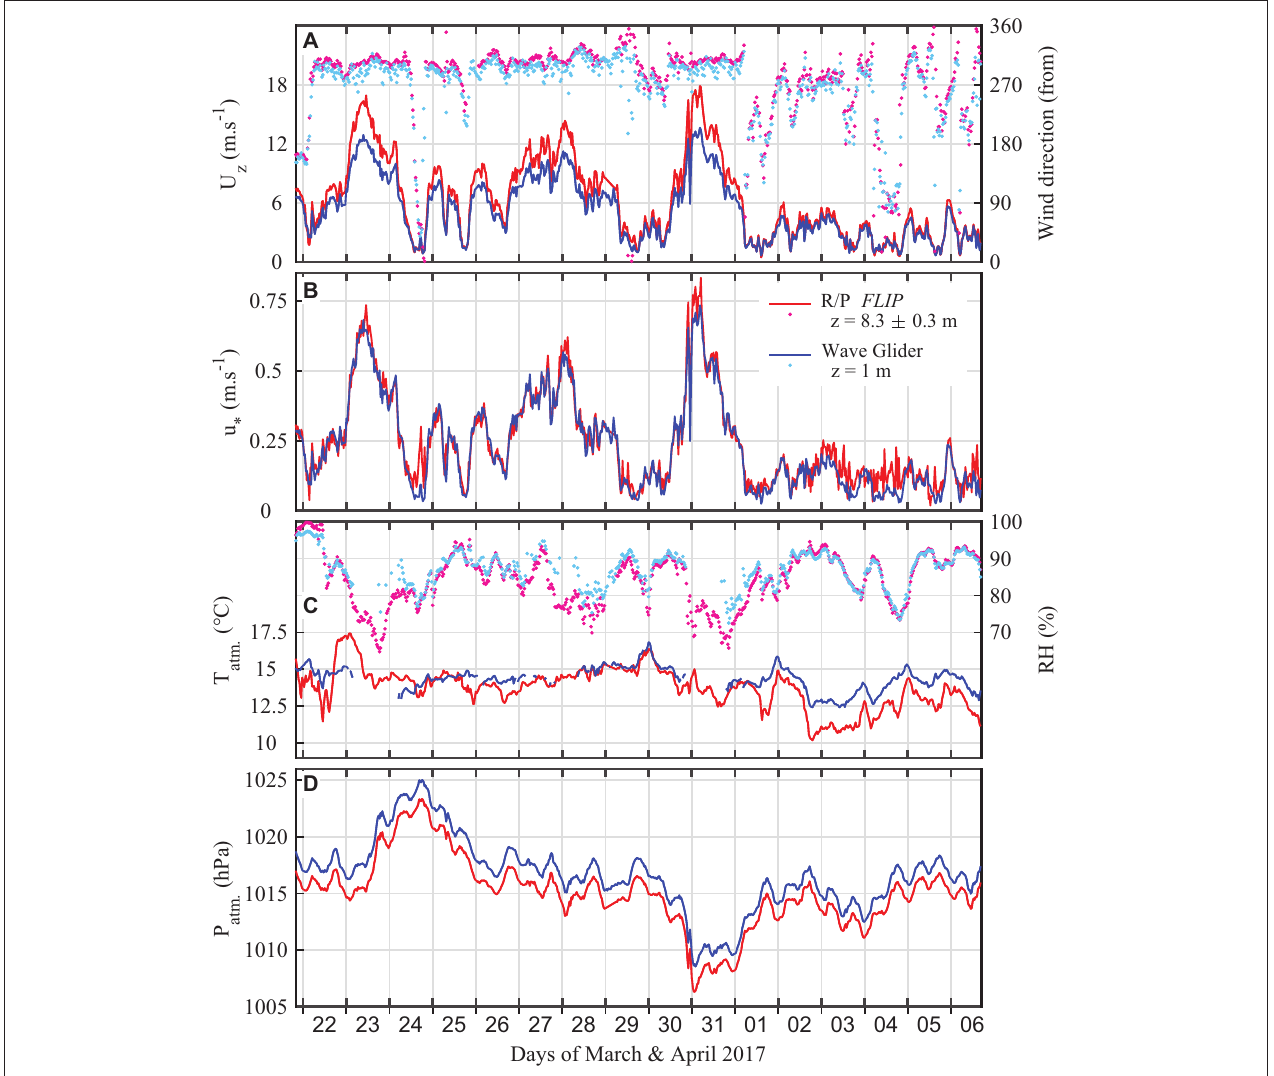
FIGURE 2 | Comparison of atmospheric variables recorded from the R/P FLIP (shades of red) and the SV2 Wave Glider Kelvin (shades of blue) during the LCDRI2017 experiment. (A) Wind speed U z (left axis, solid lines) and wind direction (right axis, dots). (B) Wind stress u measured using the eddy-covariance technique on the R/P ∗ FLIP and using Charnock’s relationship on the Wave Glider. (C) Atmospheric temperature (left axis, solid lines) and relative humidity (right axis, dots). (D) Atmospheric pressure. For all panels, variables are expressed at the height they were measured, i.e., 1 m above the surface layer for the Wave Glider and 8.3 m above the mean sea level for the R/P FLIP . In (C) , gaps in the Wave Glider data correspond to measurements that were discarded because they were associated with periods of high wind and waves when the Wave Glider was subject to frequent capsizes, leading to abnormal values of the atmospheric temperature and relative